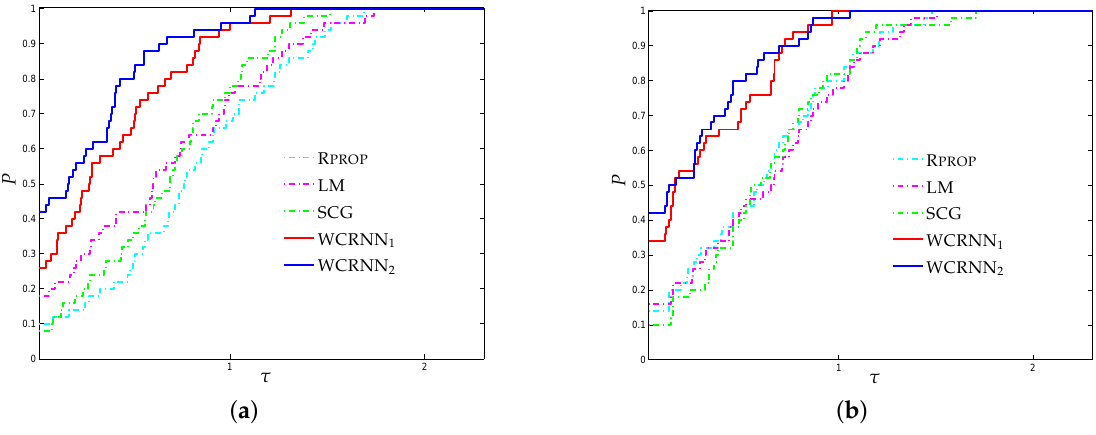
Figure 1. Log 10 scaled performance profiles for the bank management classification problem. The performance profile plots, for every τ ≥ 1, the proportion P ( τ ) of simulations for which any training algorithm has a performance within a factor τ of the best algorithm. ( a ) F 1 -score. ( b )